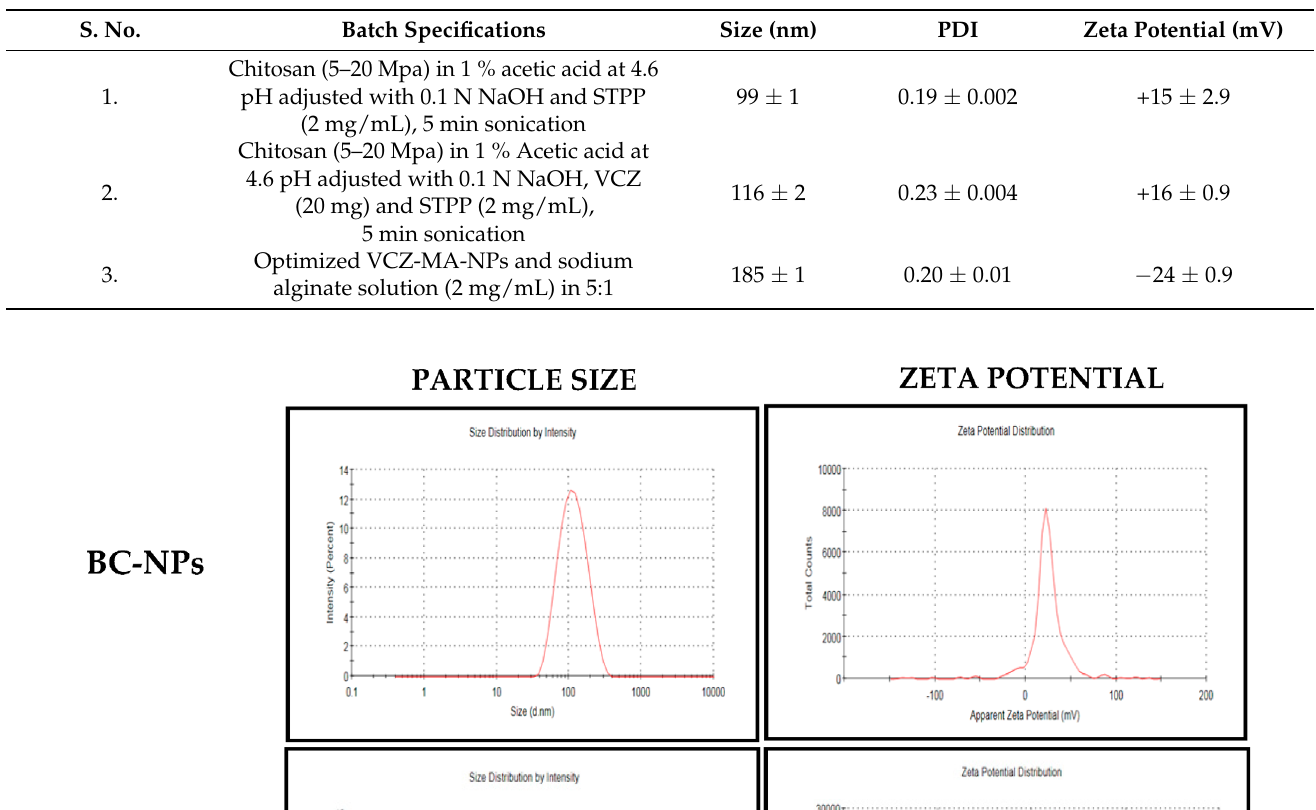
Table 7. Particle size, PDI, and zeta potential of optimized batches, (1) blank chitosan NPs, (2) VCZ-MA-NPs, and (3) VCZ-MP-NPs. Bold data are represented as mean ± SD ( n = 3).